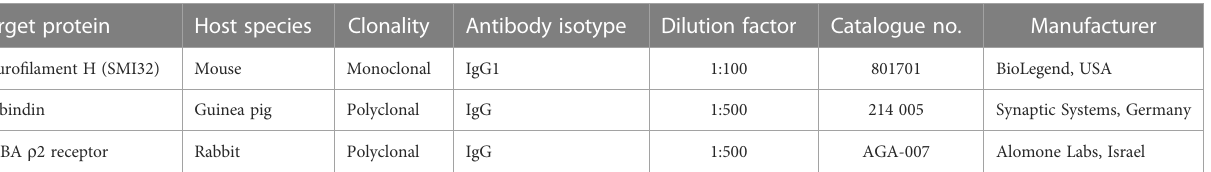
TABLE 1 The following primary antibodies were used.